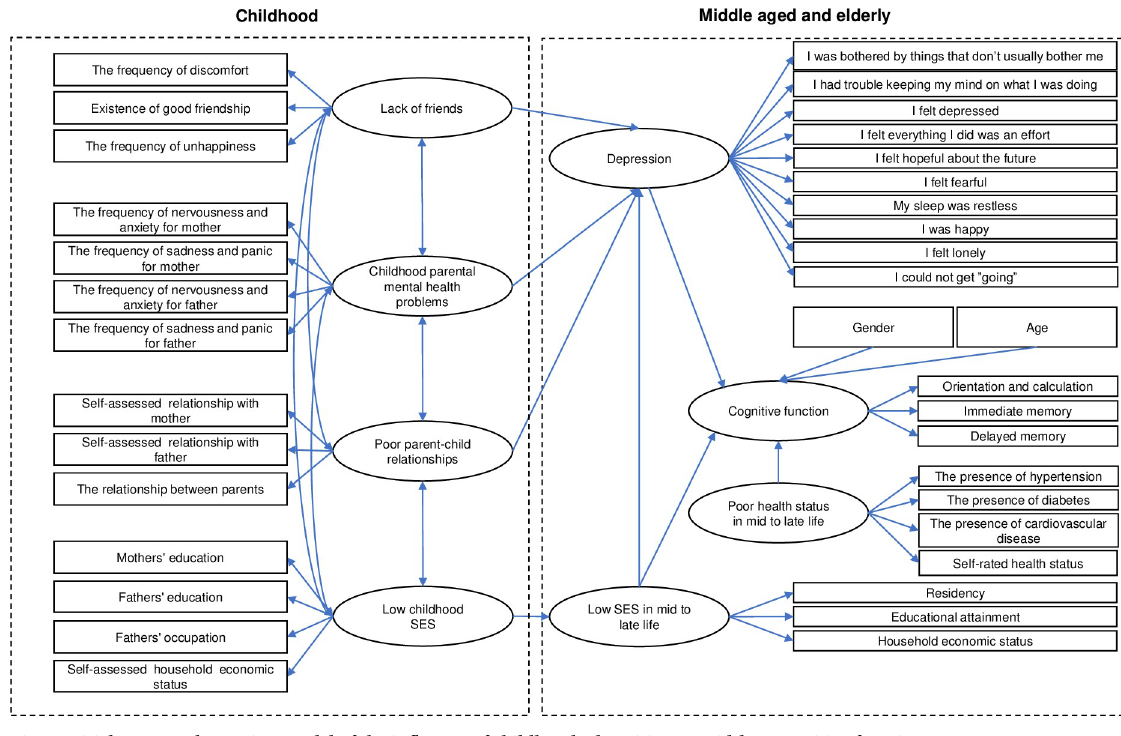
Fig 1. Initial structural equation model of the influence of childhood adversities on mid-late cognitive